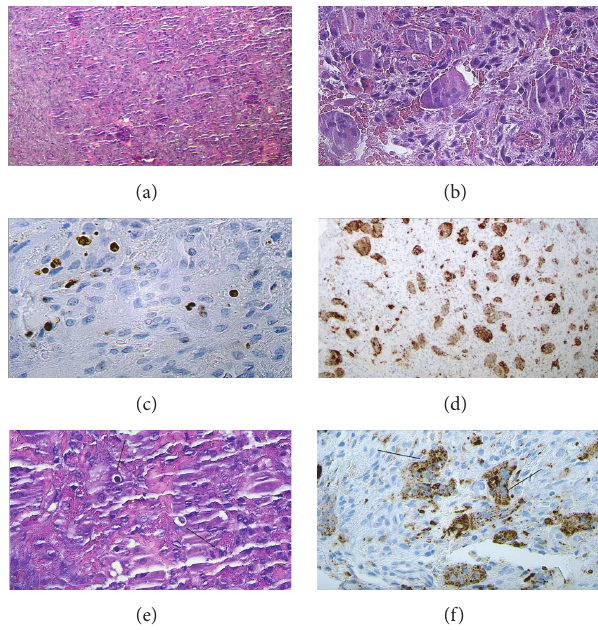
Figure 3: Central giant-cell granuloma (CGCG). (a) A lobulated mass of proliferating connective tissue containing many giant cells. (b) A larger view of the giant cell containing more than ten nuclei each. (c) Ki-67 indicates a low mitotic index. The lesion is defined as locally aggressive but cannot be considered as a true neoplasm. (d) CD68 antibody indicates the giant cells deriving from the monocytic-macrophagic line. (e) The so-called “cannibal cells” (arrows) indicate an aggressive CGCG and could suggest likely recurrence. (f) A larger view of the monocytic-derived cannibal giant cells highlighted with CD68.